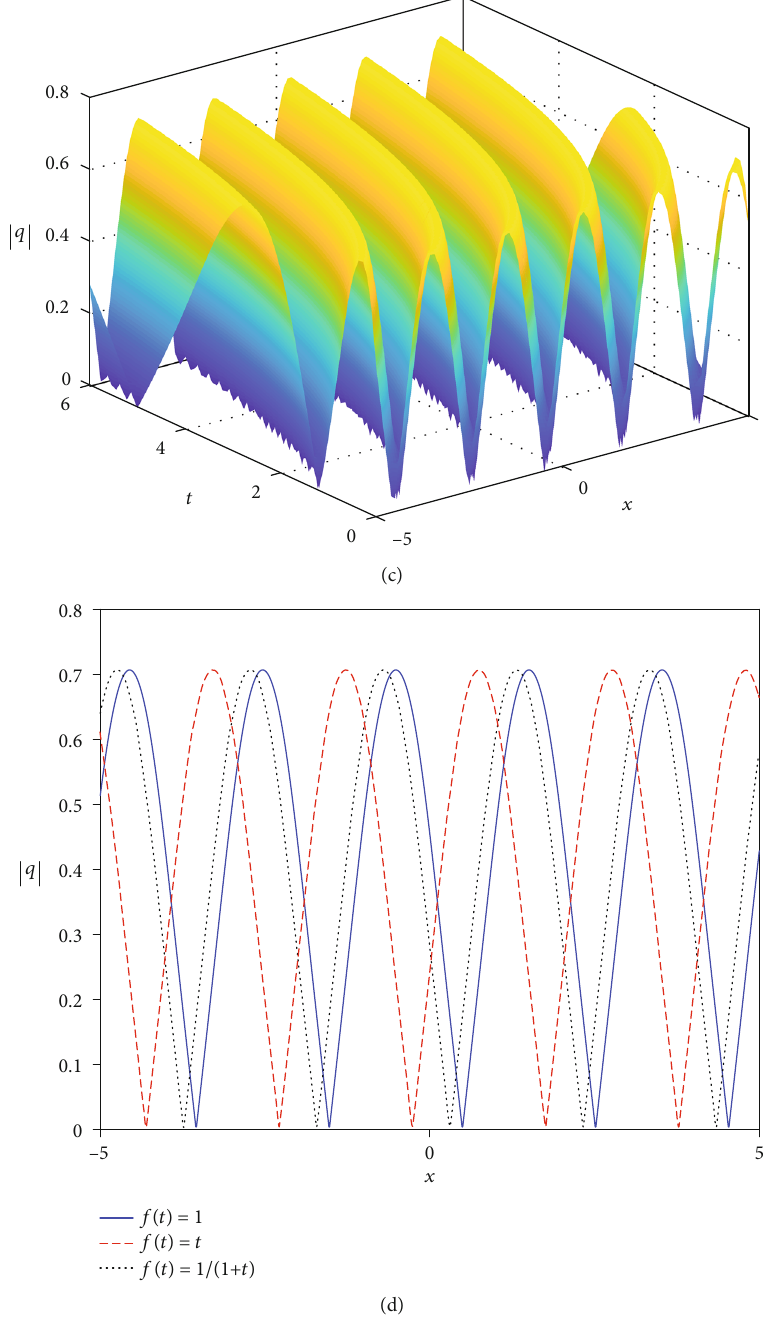
Figure 1: (a – c) The 3D wave shapes of j q j : (a) f ð t Þ = 1 , (b) f ð t Þ = t , and (c) f ð t Þ = 1/ ð 1 + t Þ . (d) The wave propagates along the x